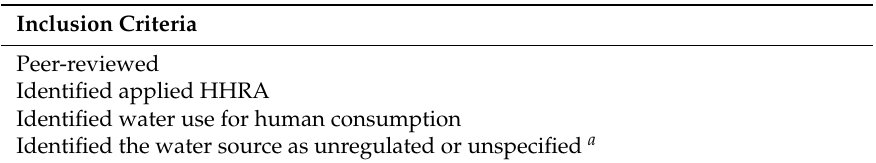
Table 1. Scoping review inclusion criteria to identify human health risk assessments applied to unregulated or unspecified drinking